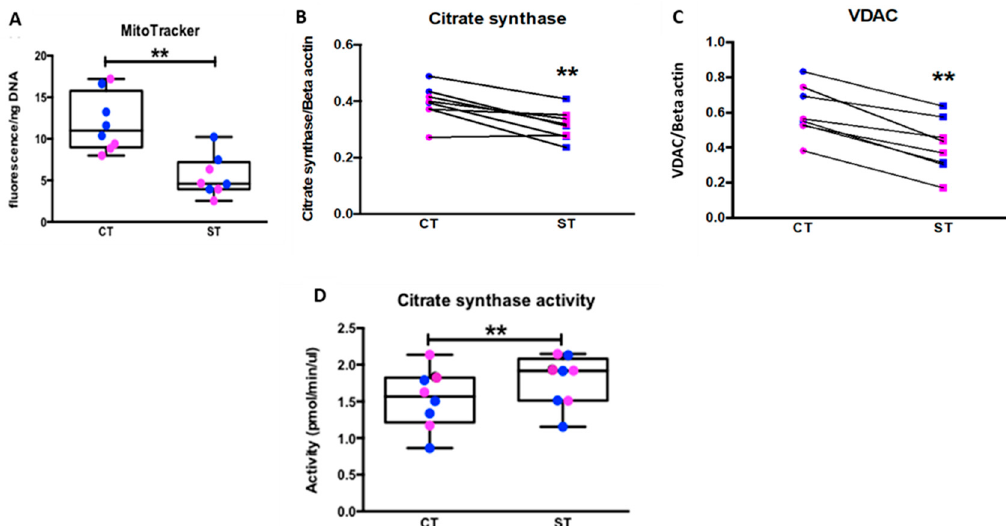
Figure 6. Mitochondrial content and activity measurements in cyto- and syncytiotrophoblast. ( A ) MitoTracker TM , ( B ) citrate synthase protein, and ( C ) VDAC protein levels. ( D ) Citrate synthase activity (in picomole/min/ µ L of substrate). Male (blue, n = 4) and female (pink, n = 4). A, D: Data presented as minimum, maximum, median, 25th and 75th quartiles boxes, and whisker plots. ( B , C ): Data plotted as individual values of paired CT and ST from the same sample Male (blue, n = 4) and female (pink, n = 4) fetal sex groups combined. ** p < 0.01, (Wilcoxon test, CT vs. ST).